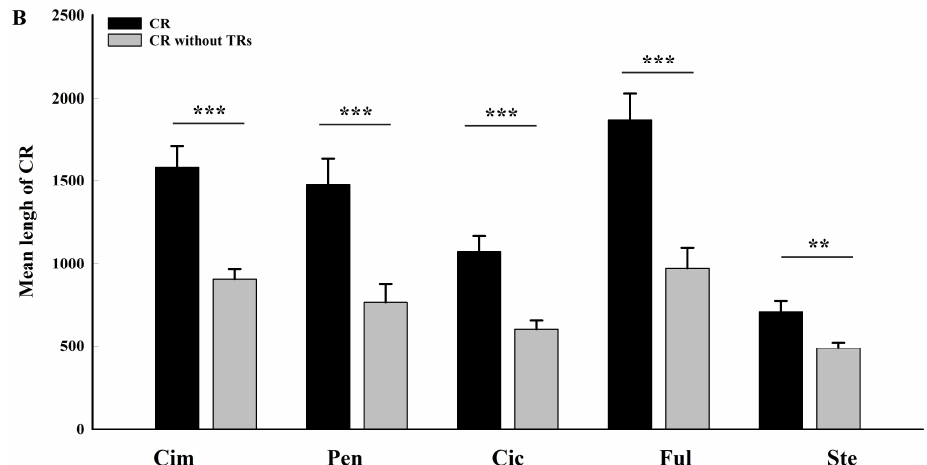
Figure 3. The variation of length between CRs and the remaining part without tandem replications (TRs) in different hemipteran groups ( A , B ). Data is displayed as mean ± SE (Standard Error). The significance level is p < 0.05. Two asterisks: p < 0.01; Three asterisks: p < 0.001. Abbreviation: Hem: Hemiptera; Het: Heteroptera; Cim: Cimicomorpha; Pen: Pentatomomorpha; Cic: Cicadomorpha; Ful: Fulgoromorpha; Ste: Sternorrhyncha.